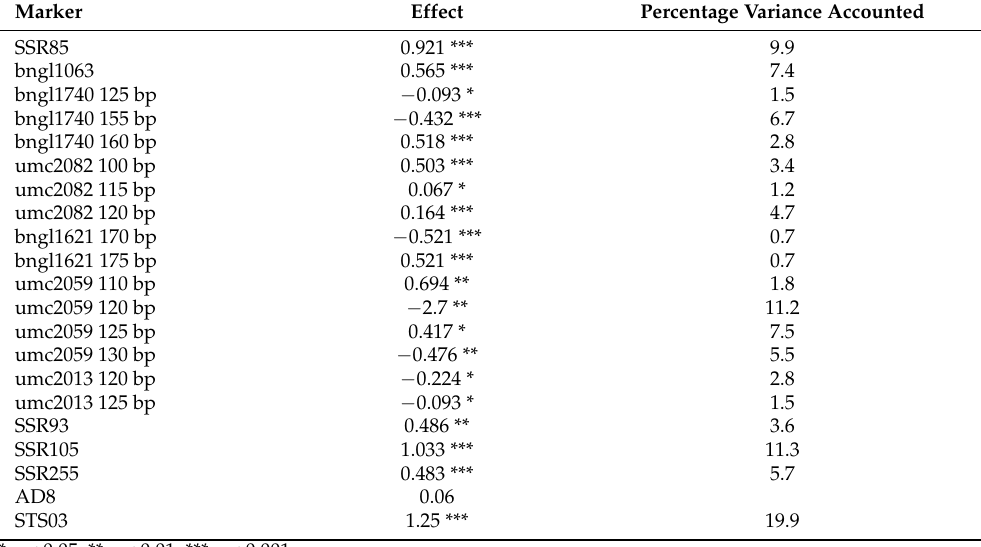
Table 5. Characteristics of molecular markers associated with Fusarium verticillioides resistance.